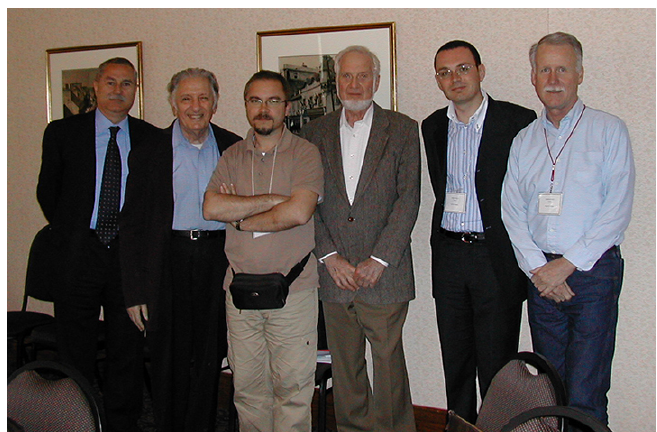
Figure 4: From left to right: Carlo Sempi, Abe Sklar, Gianfausto Salvadori, Bert Schweizer, Fabrizio Durante, and Roger Nelsen in 2004 during the DeMoSTAFI conference held in Québec from 20-22 May. This international meeting was intended as a sequel to the series of conferences on copulas and their applications that were held in Rome (1990), Seattle (1993), Prague (1996), and Barcelona